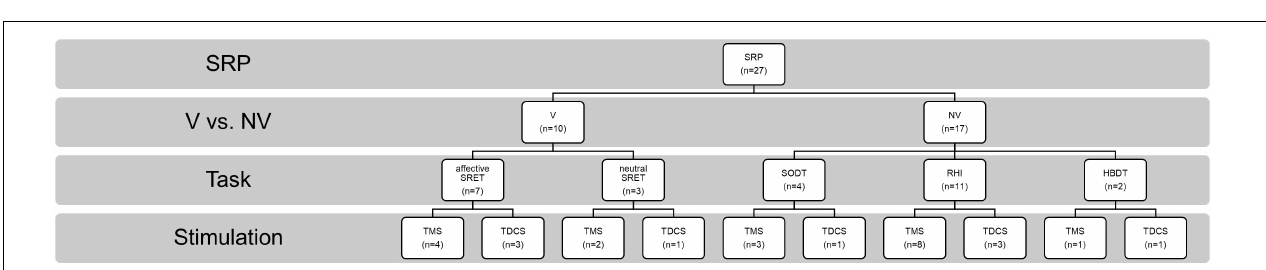
FIGURE 1 | The process of article inclusion and exclusion of the systematic literature review.